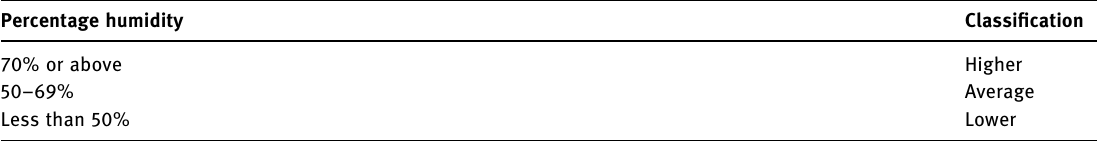
Table 3: Training of humidity values